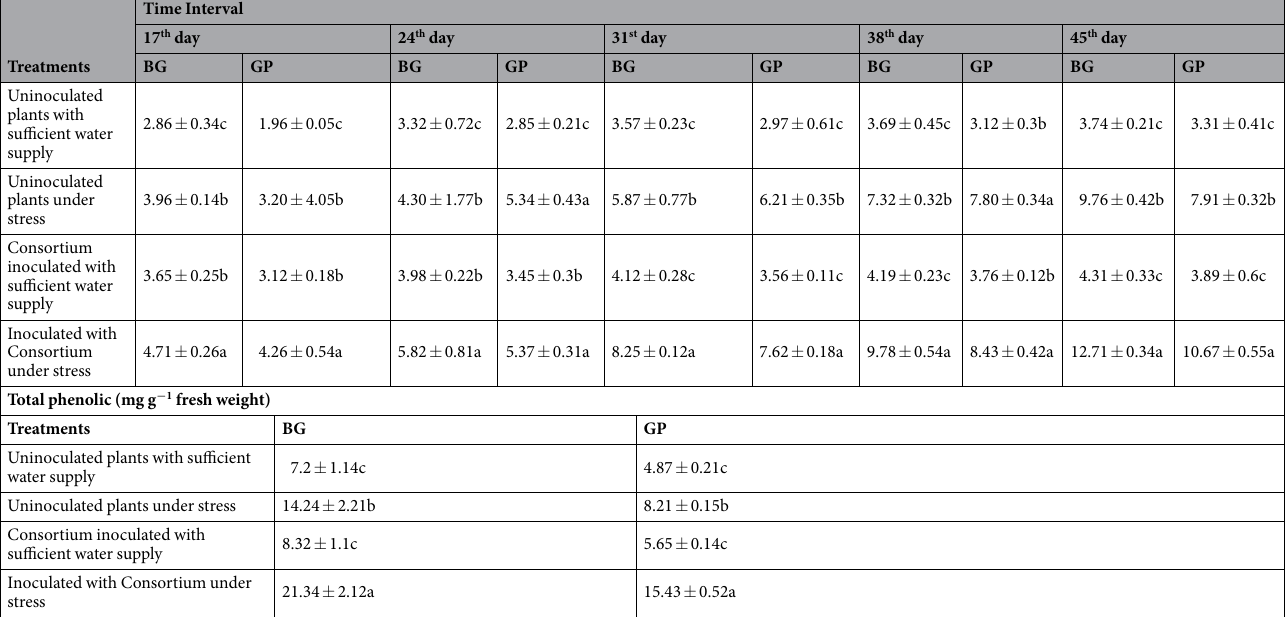
sp.) strains 48 . The lower expression pattern of ACO in consortium-treated stressed plants might be due to the substrate-based competition between ACC deaminase and ACO for binding with ACC 46 . The reduction in ACC levels would lead to a reduced ACO expression and subsequent declines in stress ethylene production. Hence, the